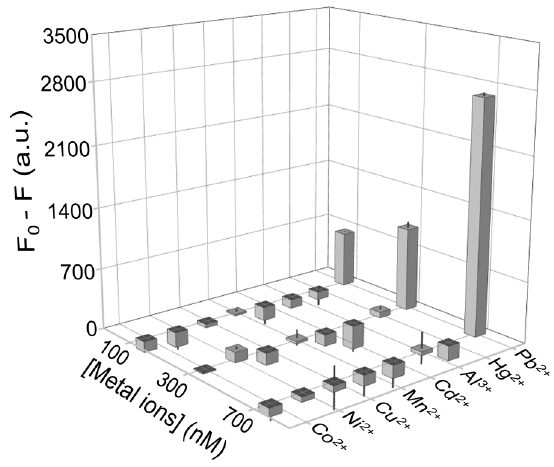
Figure 5. Corresponding signal response of the aptasensor towards different concentrations of metal ions (Pb 2+ , Cd 2+ , Co 2+ , Al 3+ , Mn 2+ , Ni 2+ , Cu 2+ , Hg 2+ ) at the concentration of 100, 300 and 700 nM.